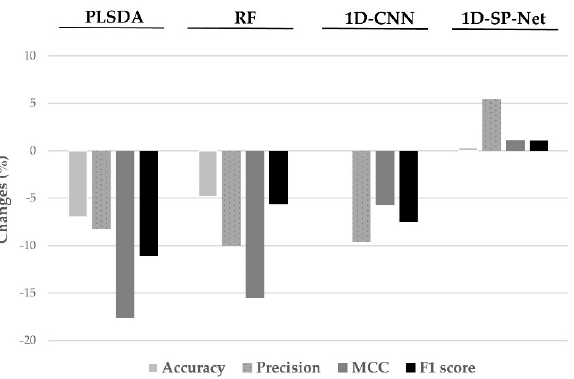
a Bold characters represent the highest values for a respective metric among the models.